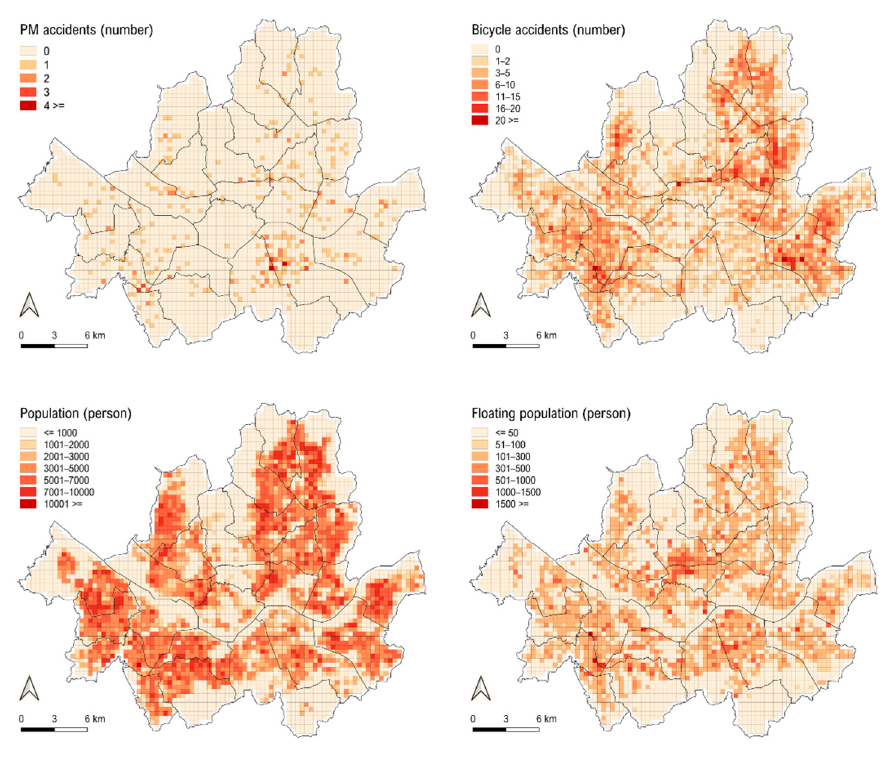
Figure 1. Spatial accident pattern . Table 3. Pearson correlation coefficients between accidents and